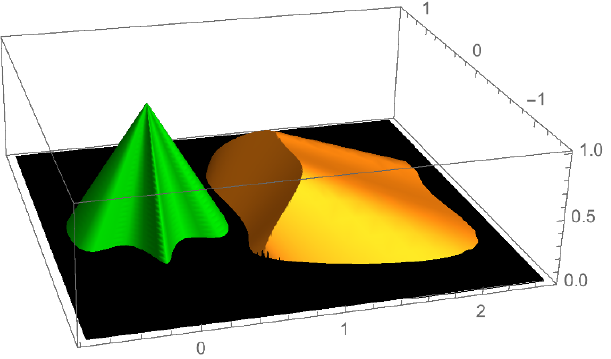
Figure 4 . The upper bound (2.12) for (cid:21) ( v ) for the two shapes considered in (cid:12)gure 3 (and for (cid:12) = 2 (cid:25)